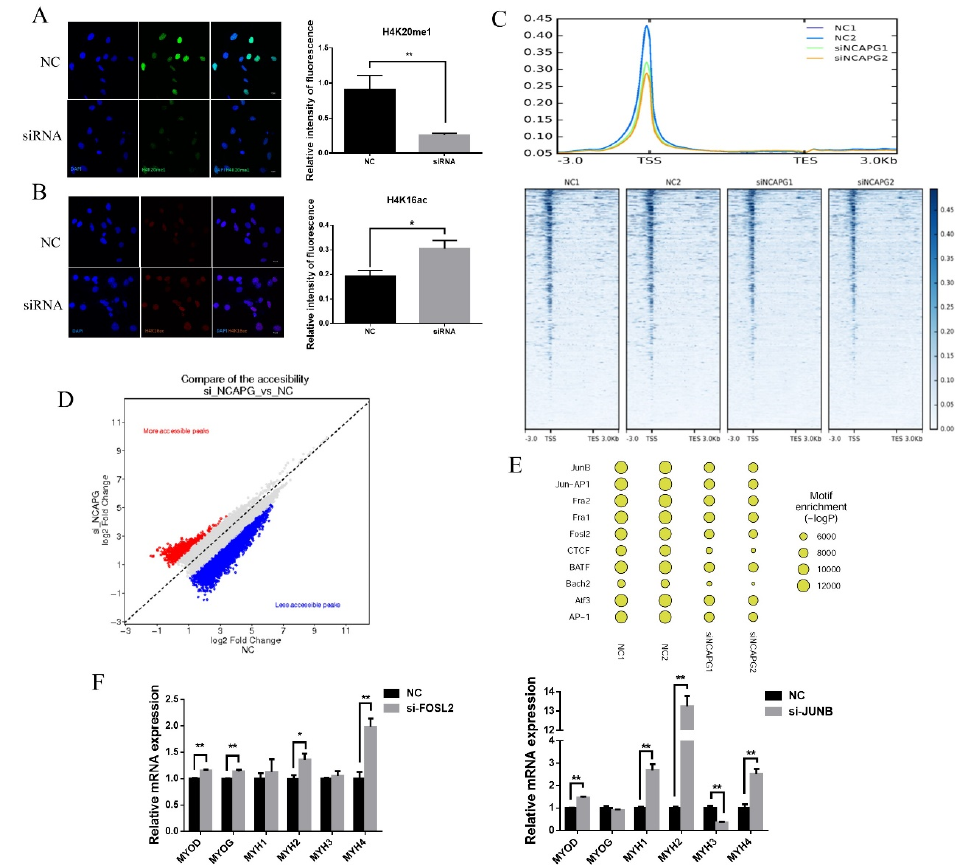
Figure 6. NCAPG knockdown altered chromatin compaction and accessibility. ( A , B ) (Left) Representative immunofluorescence images of myoblasts transfected with a negative control or si-NCAPG and stained with antibodies against H4K20me1 (green) or H4K16ac (red). DNA (DAPI) is shown in blue. Scale bars = 10 µ m. (Right) Fluorescence intensity quantification. The results are presented as the mean ± the SEM, * p < 0.05, ** p < 0.01. ( C ) ( top ) A histogram of the intensity of enriched reads (from TSS − 3 kb to TES + 3 kb) for each replicate. ( bottom ) A heatmap of ATAC-seq signal mapping with annotated TSS. ( D ) Scatterplots showing changes in chromatin accessibility between the NC and si-NCAPG groups. ( E ) TF motifs identified from ATAC-seq peaks. ( F ) ( Left ) Transcript levels of muscle-specific gene expression in AP-1 subunits (FOSL2) in depleted myoblasts. ( Right ) Transcript levels of muscle-specific gene expression in AP-1 subunits (JUNB) in depleted myoblasts. The results are presented as the mean ± the SEM from at least three independent experiments, * p < 0.05, ** p <